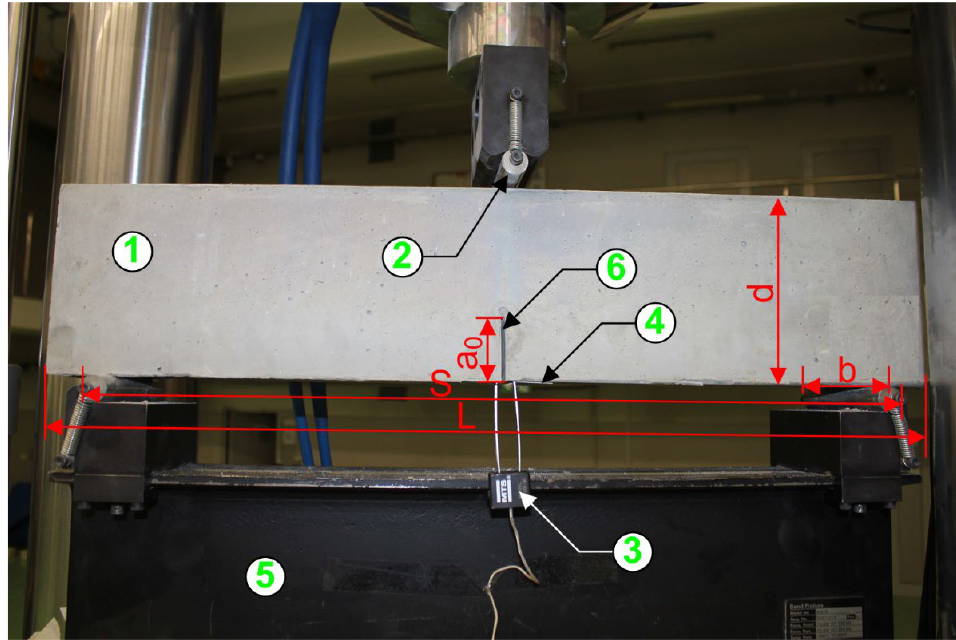
Figure 1. Three-point bending test setup: 1—specimen, 2—load, 3—clip gauge extensometer, 4—clamping test grips, 5—support, 6—initial